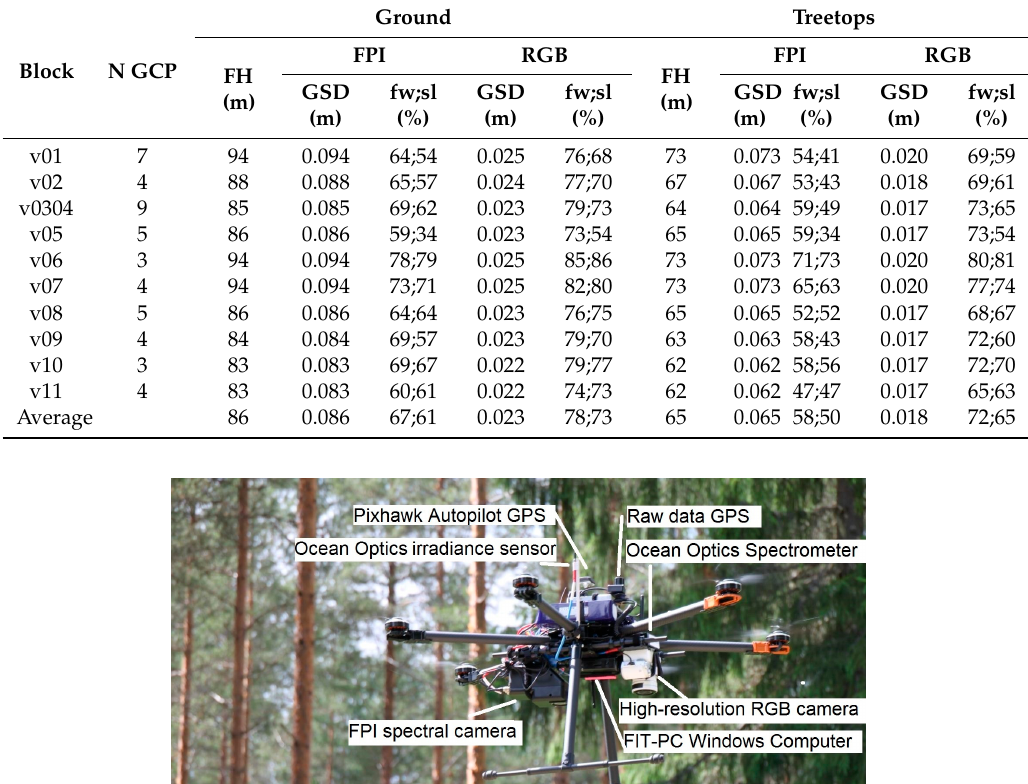
Table 4. Properties of image blocks calculated at ground level and at tree top level (N gcp: number of ground control points (GCPs), FH: flying height; fw;sl: forward and side overlaps; FPI: Fabry–Pérot interferometer, GSD: ground sampling distance).